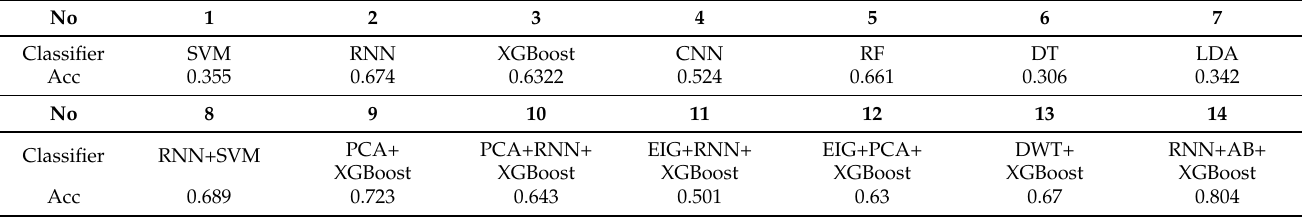
Table 4. Comparison of various classification methods. AB denotes attention-based method; RF denotes Random Forest; DT denotes Decision Tree; EIG denotes the eigenvector-based dimensionality reduction method used in eigenface recognition; PCA denotes Principal Component Analysis; DWT denotes Discrete Wavelet